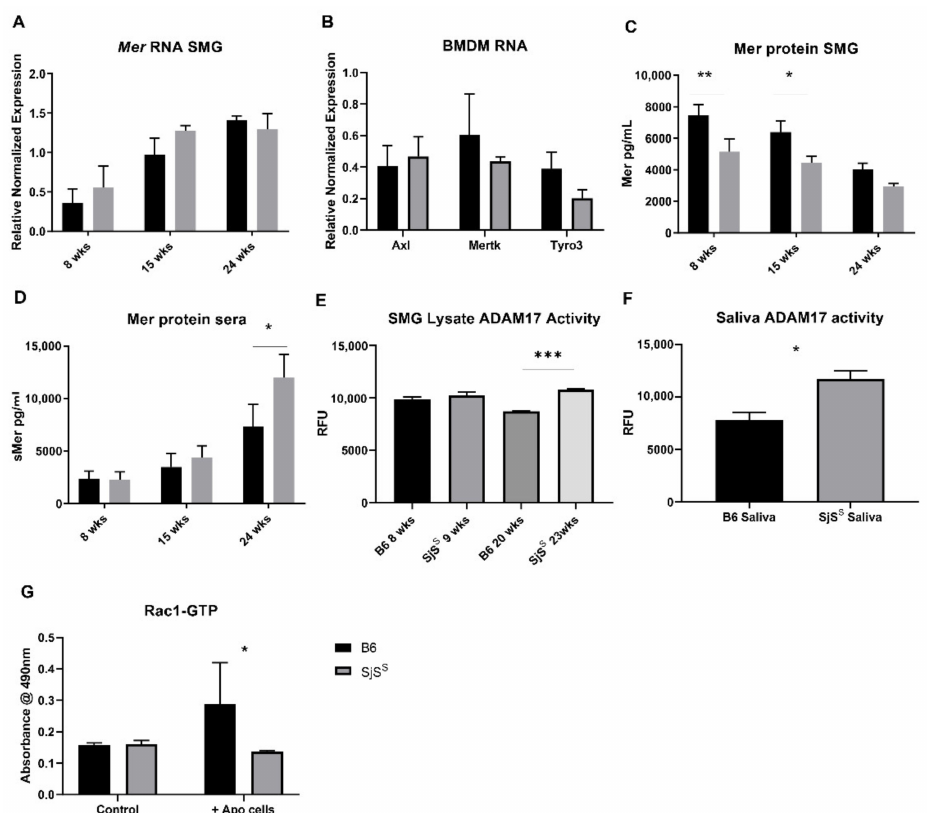
Figure 4. Elevated ADAM17 activity and sMer are observed in SjS S mice. ( A , C , D ) Sera were collected from B6 (n = 5) and SjS S mice (n = 5) at 8, 15, and 24 weeks. SMG was also excised and processed for RNA and protein using a PARIS kit. ( A ) Mer RNA expression in SMG was analyzed via RT qPCR, and expression was reported relative to GAPDH as ∆∆ Cq. ( B ) TAM RNA expression in BMDMs was analyzed via RT qPCR, and expression was reported relative to HPRT as ∆∆ Cq. ( C ) SMG protein lysate was diluted to 1 mg/mL and analyzed for Mer protein using a mouse Mer ELISA kit (RnD Systems). ( D ) Mouse sera were diluted 1:20, and Mer protein was measured using a mouse Mer ELISA kit. ( E ) SMG lysate from young (8–9 weeks) and old (20–23 weeks) B6 (n = 3) and SjS S mice (n = 3) was diluted to 5 ug of protein and ADAM17 cleaving activity was measured using a SensoLyte ADAM17 activity kit. ( F ) Freshly collected mouse saliva from B6 (n = 5) and SjS S mice (n = 5) (38–45 weeks) was diluted 1:100 and ADAM17 cleaving activity was measured using the same kit as ( E ). ( G ) Rac1 GLISA kit was used to measure Rac1 activation following treatment of BMDMs with apoptotic cells. The statistical significance was calculated by two-tailed unpaired t -tests or one-way ANOVA where error bars indicate SEM * p < 0.05, ** p < 0.01, and *** p <